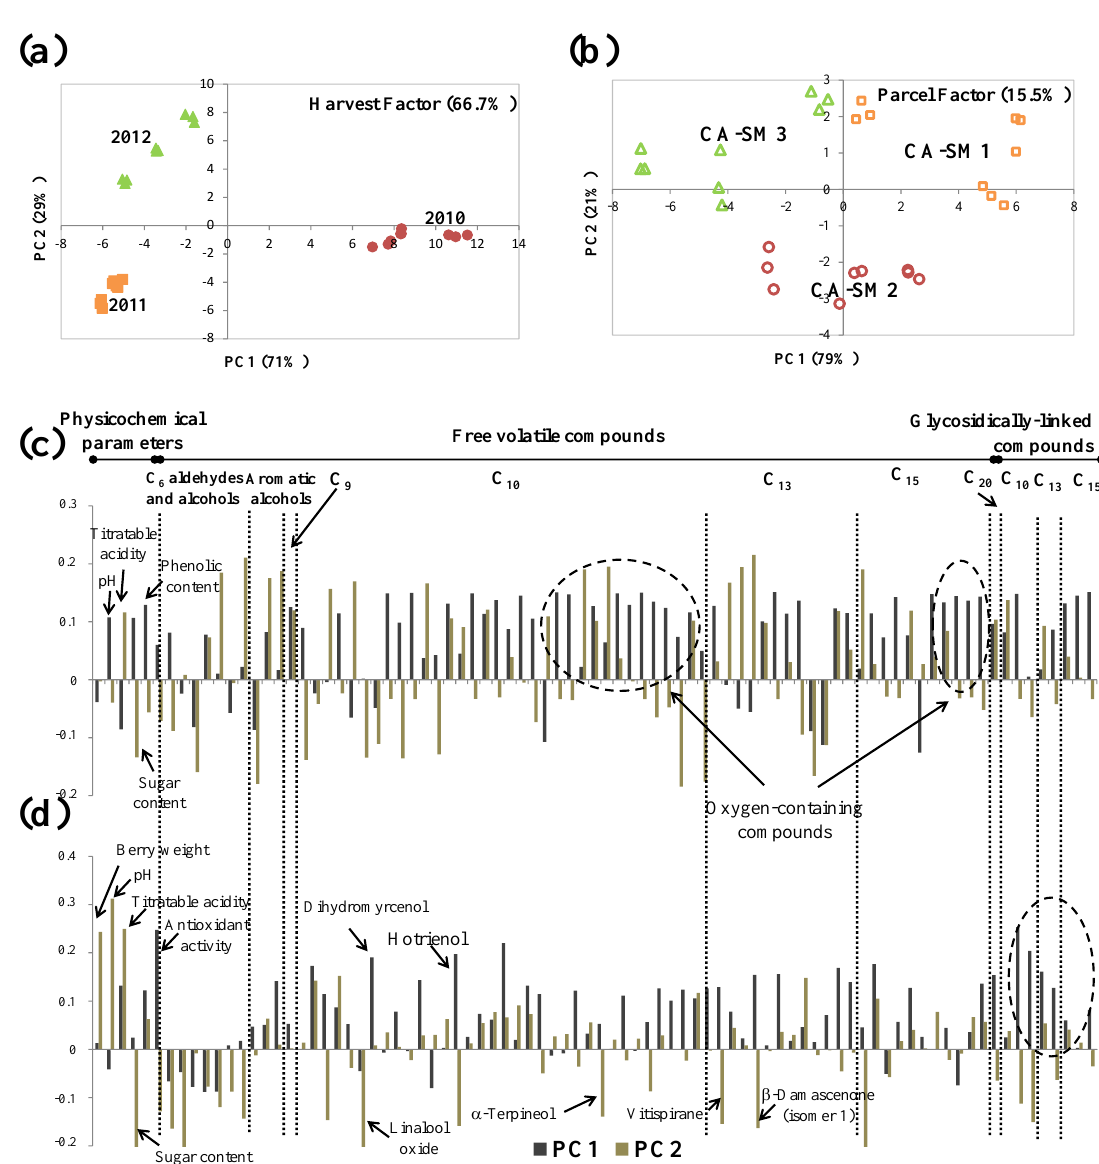
Figure 8. ASCA scores plot for ( a ) harvest and ( b ) parcel factors, and the corresponding variable loadings plot ( c , d ), respectively, obtained for Castelão, at technological maturity (significance test reported on Table 4). Each variable is normalized separately by dividing by its standard deviation value. Touriga Nacional For Touriga Nacional variety, harvest year accounted for 59.3% of the total data set variance (Table 4). The PC1 of the scores plot allowed the separation of the 2010 harvest (PC1 positive) from the 2012 and 2011 harvests placed in PC1 negative side and near to the origin, respectively (Figure 9a). SM2 (PC1 positive) had lower berry weight and higher content of sugars, phenolic and monoterpenic compounds, mainly the oxygen-containing ones, and higher antiradical activity. Additionally, PC2 distinguishes TN-SM1 (PC2 negative) from TN-SM3, which